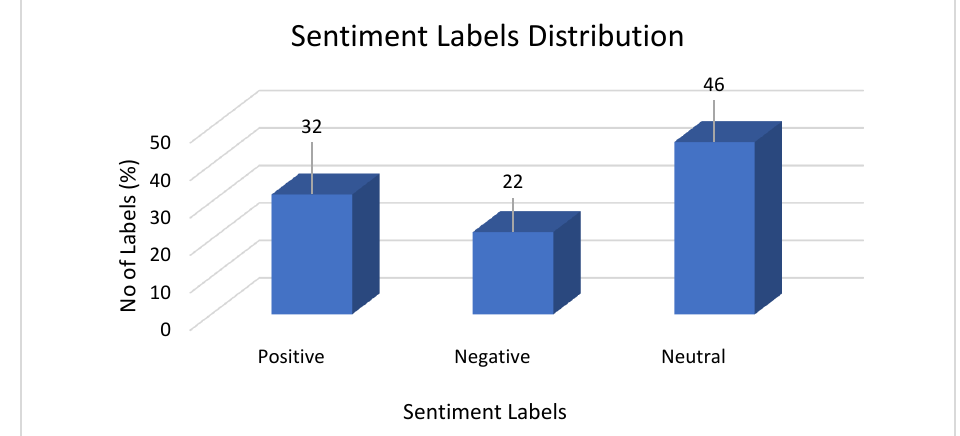
Figure 1. Bar chart showing the distribution of sentiment labels in the text dataset. The dataset contains hate speech tweets prevalent during the capitol riot. To summa ‐ rize the most popular words, we took the help of word cloud visualization to understand the distribution of hate words in the dataset. The tweets posted during the riot consisted of words, such as America ‐ first, Donald trump, maga, stop Biden, etc., signifying the ha ‐ tred among the users, as evident through the word cloud shown in Figure 2.